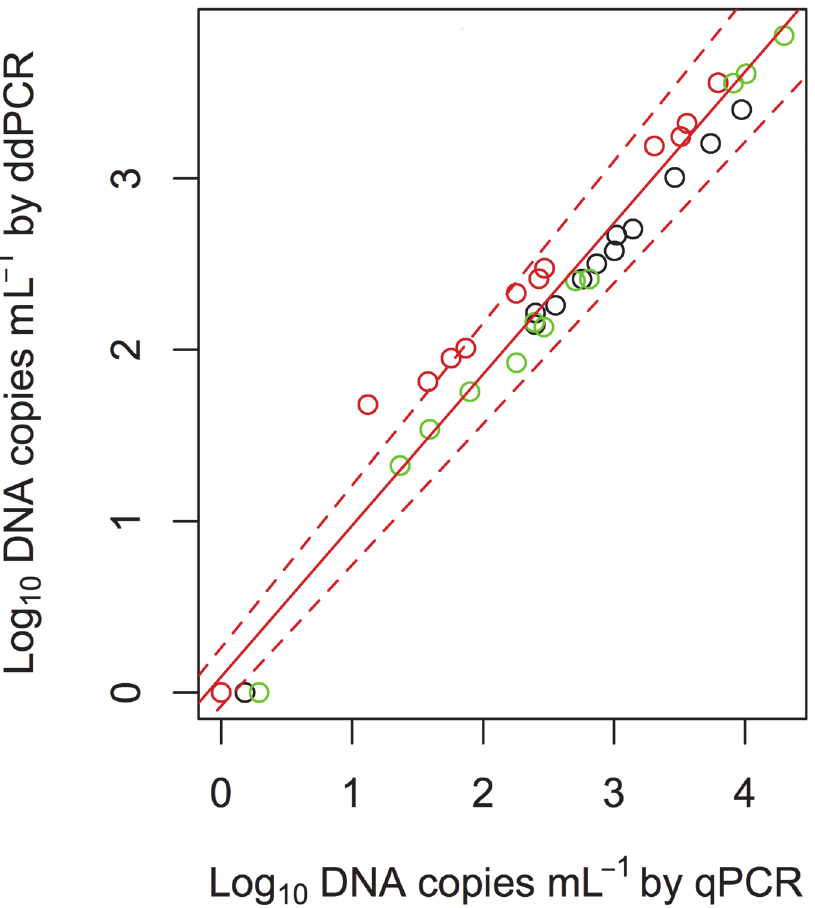
Fig 1. Relationships between eDNA concentrations of common carp in mesocosms that were measured using qPCR and ddPCR. Black, red, and green symbols indicate samples collected on days 1, 2, and 3, respectively. Solid red and dashed red lines indicate Type II regression and 95% CI,